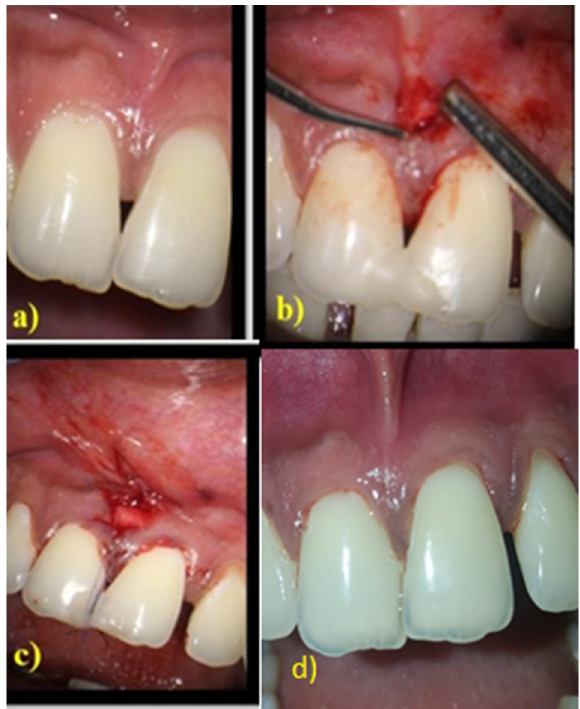
Figure 2. Surgical protocol of control group: ( a ) Preoperative image of 11 and 21 in CTG group. ( b ) Tunnel preparation in CTG group. ( c ) Vertical mattress sutures placed along the composite stopper in the CTG group. ( d ) Six months postoperative image in the CTG group. CTG: Connective Tissue Graft